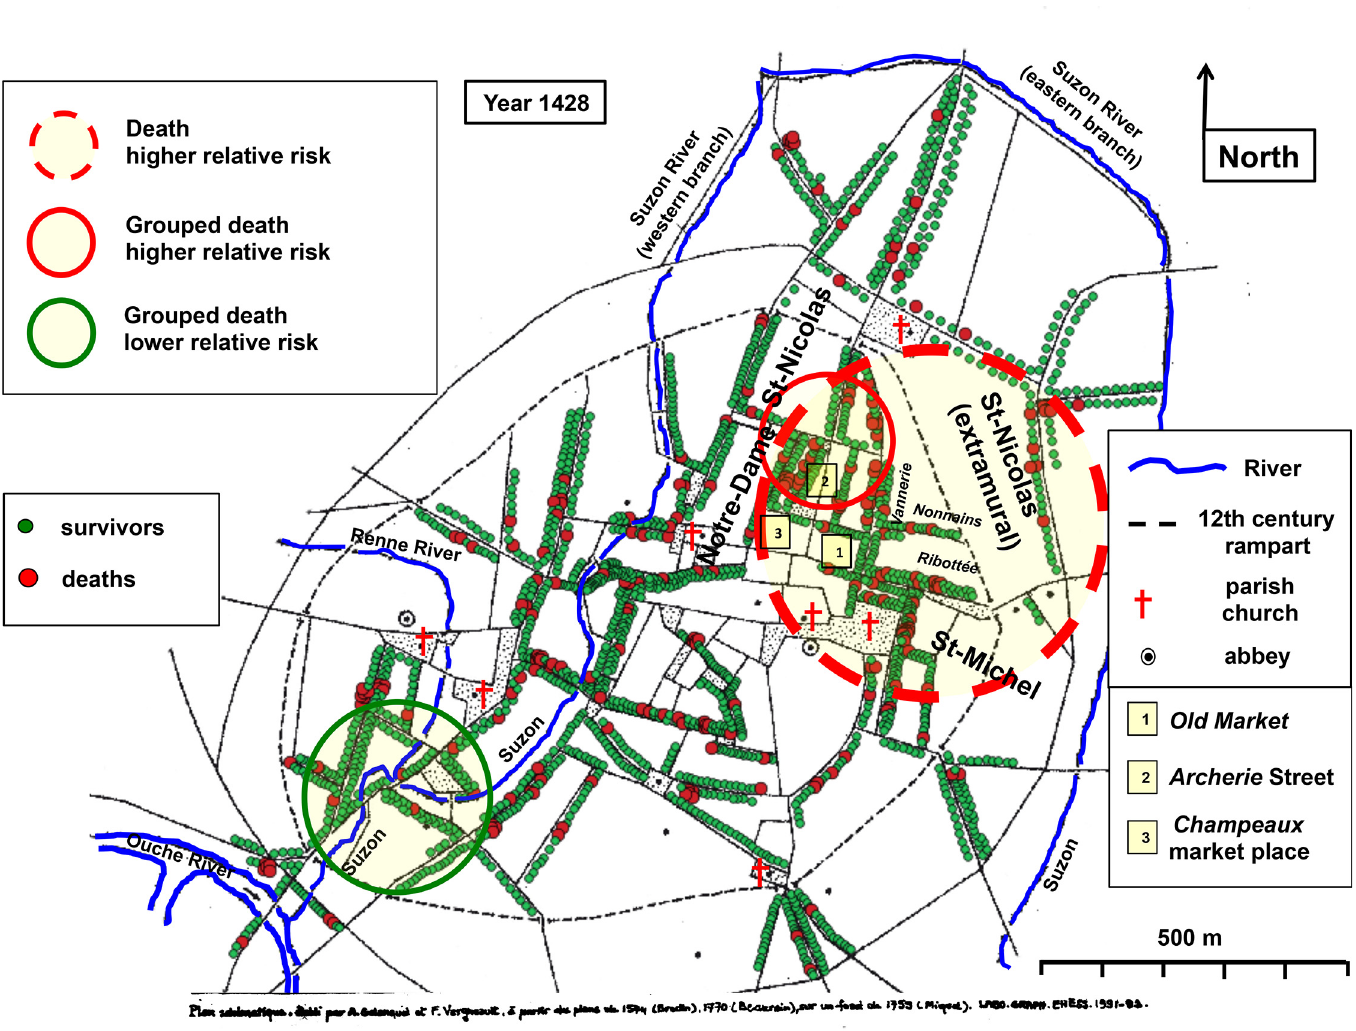
Fig 4. Cartography of death in 1428. Georeferenced map of medieval Dijon. Rivers as blue lines. Parish churches, abbeys and a number of prominent places are indicated. The 12th century rampart is shown by dotted lines. Each point corresponds to a surviving head of household (green points) or to a registered death (larger red points). Yellow area circled in dotted red line: spatial cluster where the relative risk of death doubled. Yellow area circled in solid red line: cluster with a higher relative risk of grouped death. Yellow area circled in green: cluster with a null relative risk of grouped death. Historical evidence of the location of the statistically significant clusters is presented in S10 Text